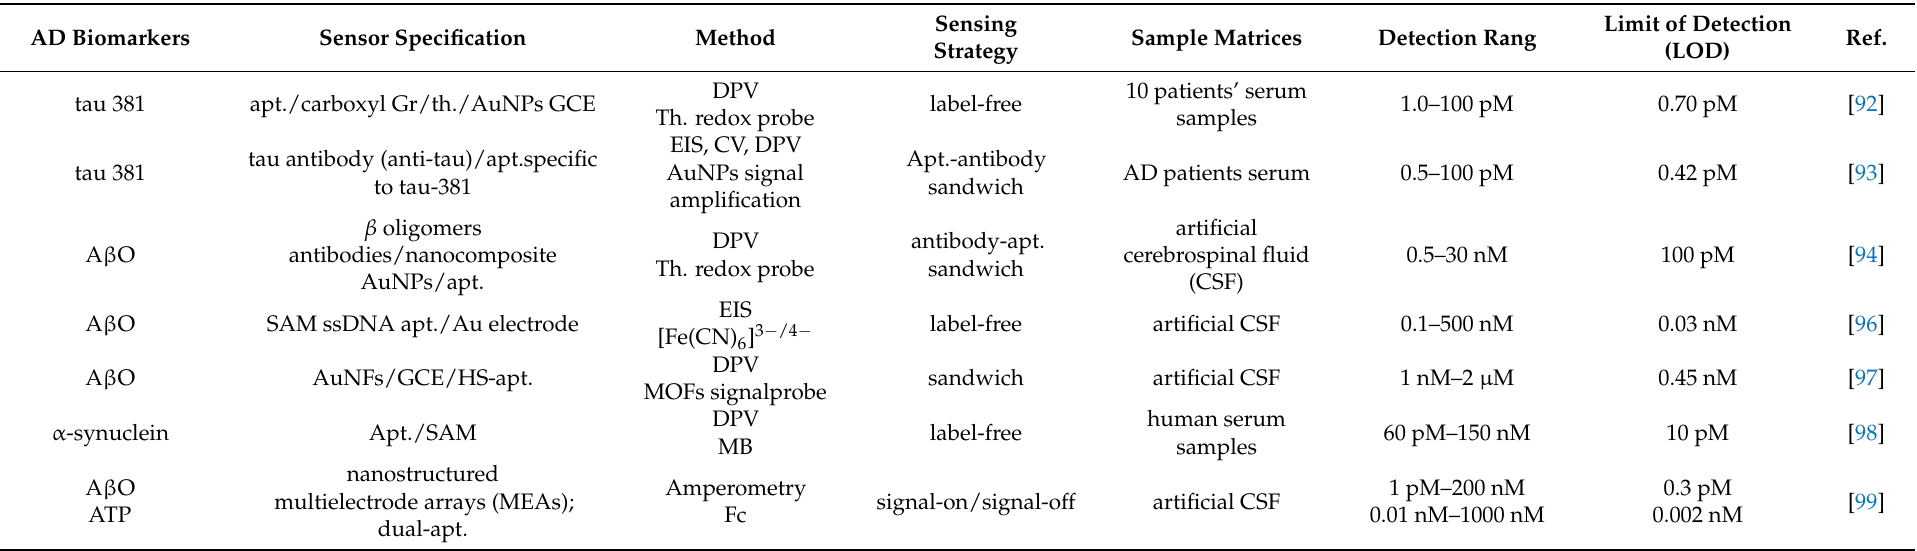
Table 2. Specifications of electrochemical aptasensors for Alzheimer’s disease (AD)